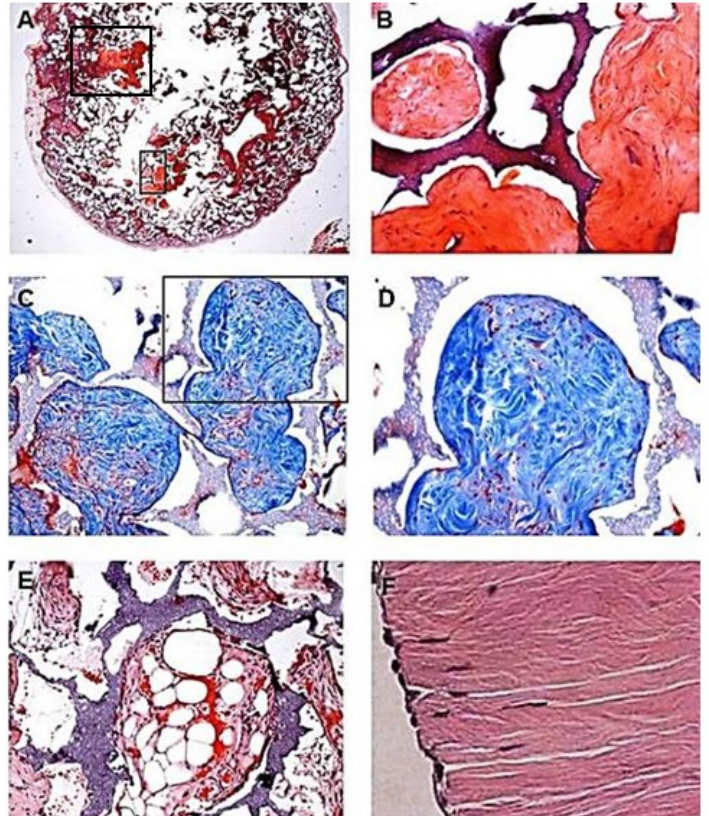
Figure 6. Formation of fibrocartilage in PVA sponge discs containing α -gal nanoparticles (10 mg/mL) and microscopic porcine meniscus cartilage homogenate as ECM (50 mg/mL), implanted subcutaneously for 5 weeks in anti-Gal producing GT-KO mice. ( A ). PVA sponge disc section for demonstration of fibrocartilage growth (stained red) in areas marked with rectangles (H&E × 10). ( B ) Magnification of the inset in ( A ) demonstrating the fibrocartilage growth (red). The PVA sponge material is stained purple-red. ( C ). Mason-trichrome staining of the collagen fibers blue in an area similar to that in ( B ) ( × 100). ( D ) The inset in ( C ) ( × 200) demonstrates fibrocartilage formation consisting of multiple collagen fibers. The nuclei of the few fibrochondroblasts are stained purple. ( E ) Control sponge disc containing only meniscus cartilage ECM homogenate, displaying adipocytes and no fibrocartilage formation (Mason-trichrome × 100). ( F ). Structure of porcine meniscus fibro- cartilage displaying parallel organization of fibrochondrocytes and the collagen fibers they produce (H&E, ×200). Representative sections are from 5 GT-KO mice per group. Reprinted with permission from ref. [57].